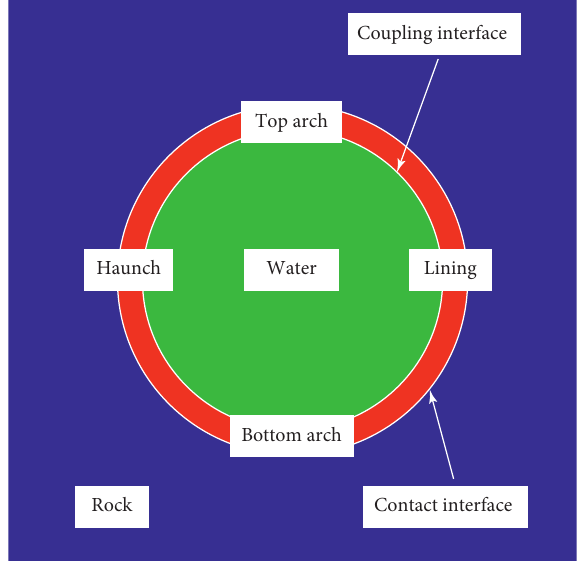
Figure 4: Layout of monitoring